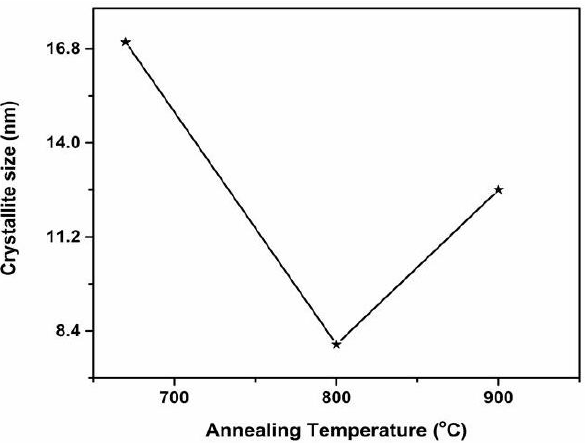
Figure 4. Influence of annealing temperature on crystalline size of SiGe thin films.